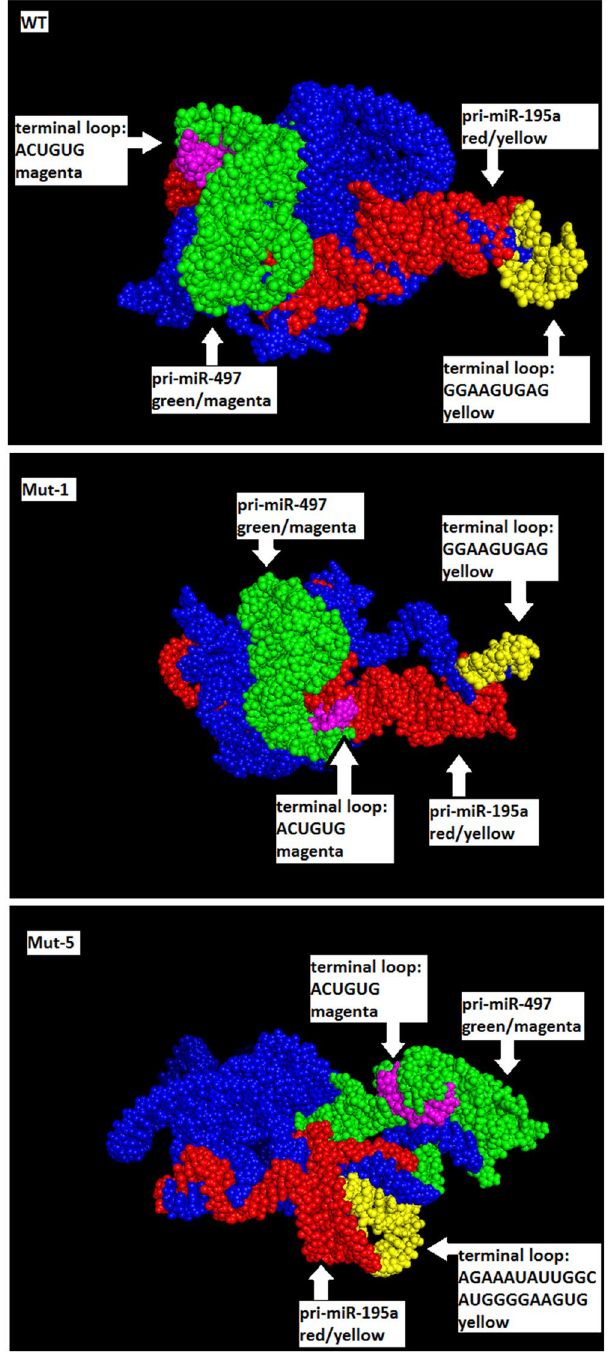
Figure 2. Effect of CRISPR/Cas9 editing in the tertiary structure of miR-497~195 cluster. Computational simulation of the 3D structure (generated by vsfold5 - with pseudoknots – as input to RNAComposer, pdb-file visualised by PyMOL) of the primiR-497~195 in unedited (wt), mutant harbouring a deletion of 1 nt (mut1) and a mutant harbouring a deletion of 18 nt (mut5). MiR-497a stem loop is depicted in green and its’ terminal loop in magenta. MiR-195a stem loop is depicted in red and its’ terminal loop in